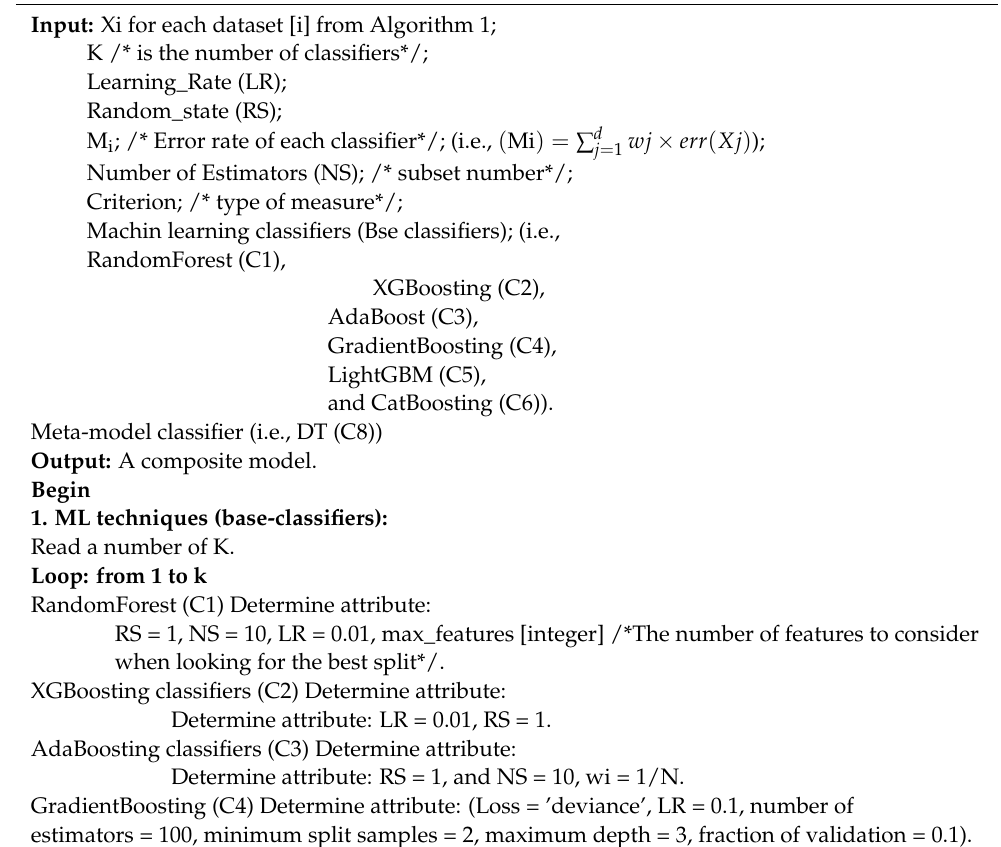
Algorithm 2. ML and meta-model